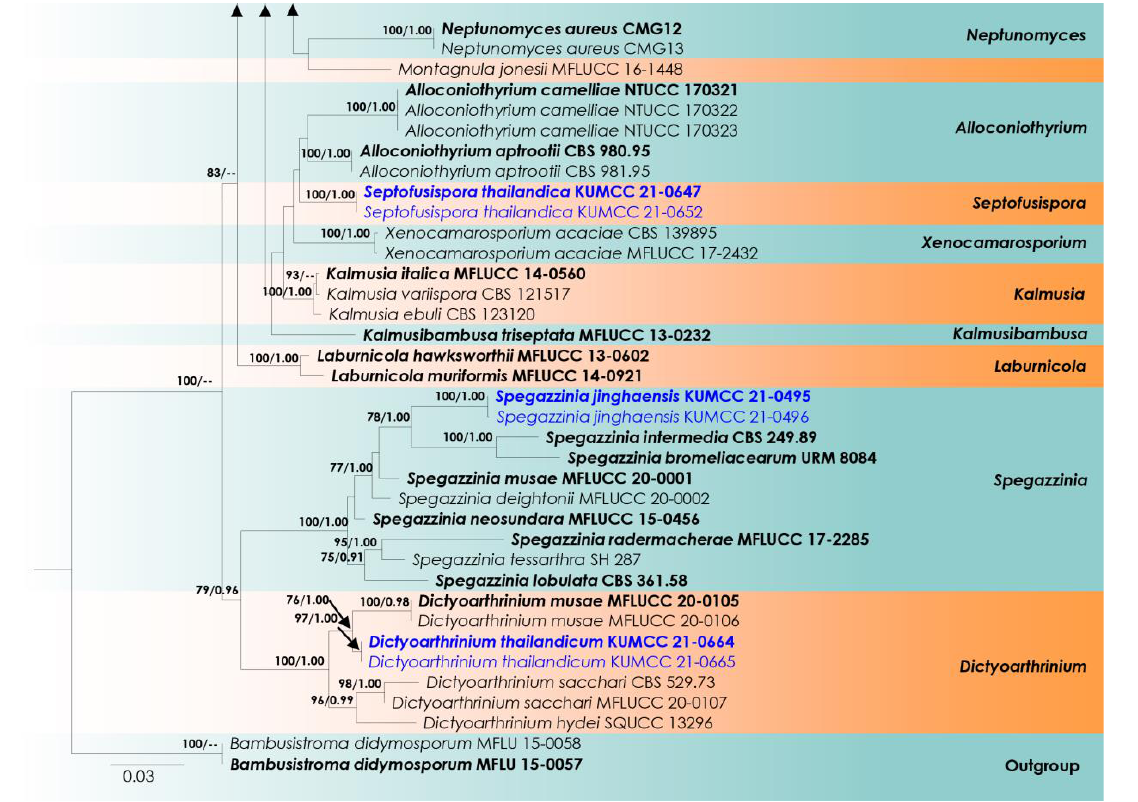
Figure 1. Phylogram generated from ML analysis based on the combined SSU, LSU, ITS, and tef 1- α dataset. Bootstrap support values for ML equal to or higher than 75%, and BYPP equal to or greater than 0.90 are shown above the nodes. The ex-type strains are in bold, and new isolates are in blue. The tree is rooted with Periconia didymospora (MFLU 15-0057 and MFLU